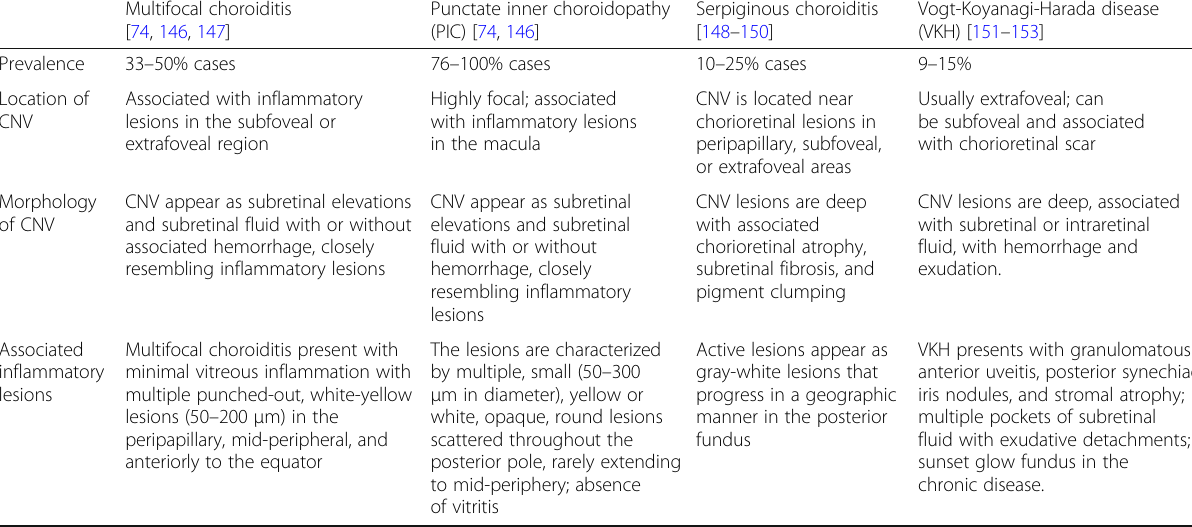
Table 3 Features of inflammatory choroidal neovascularization (CNV) commonly associated with non-infectious